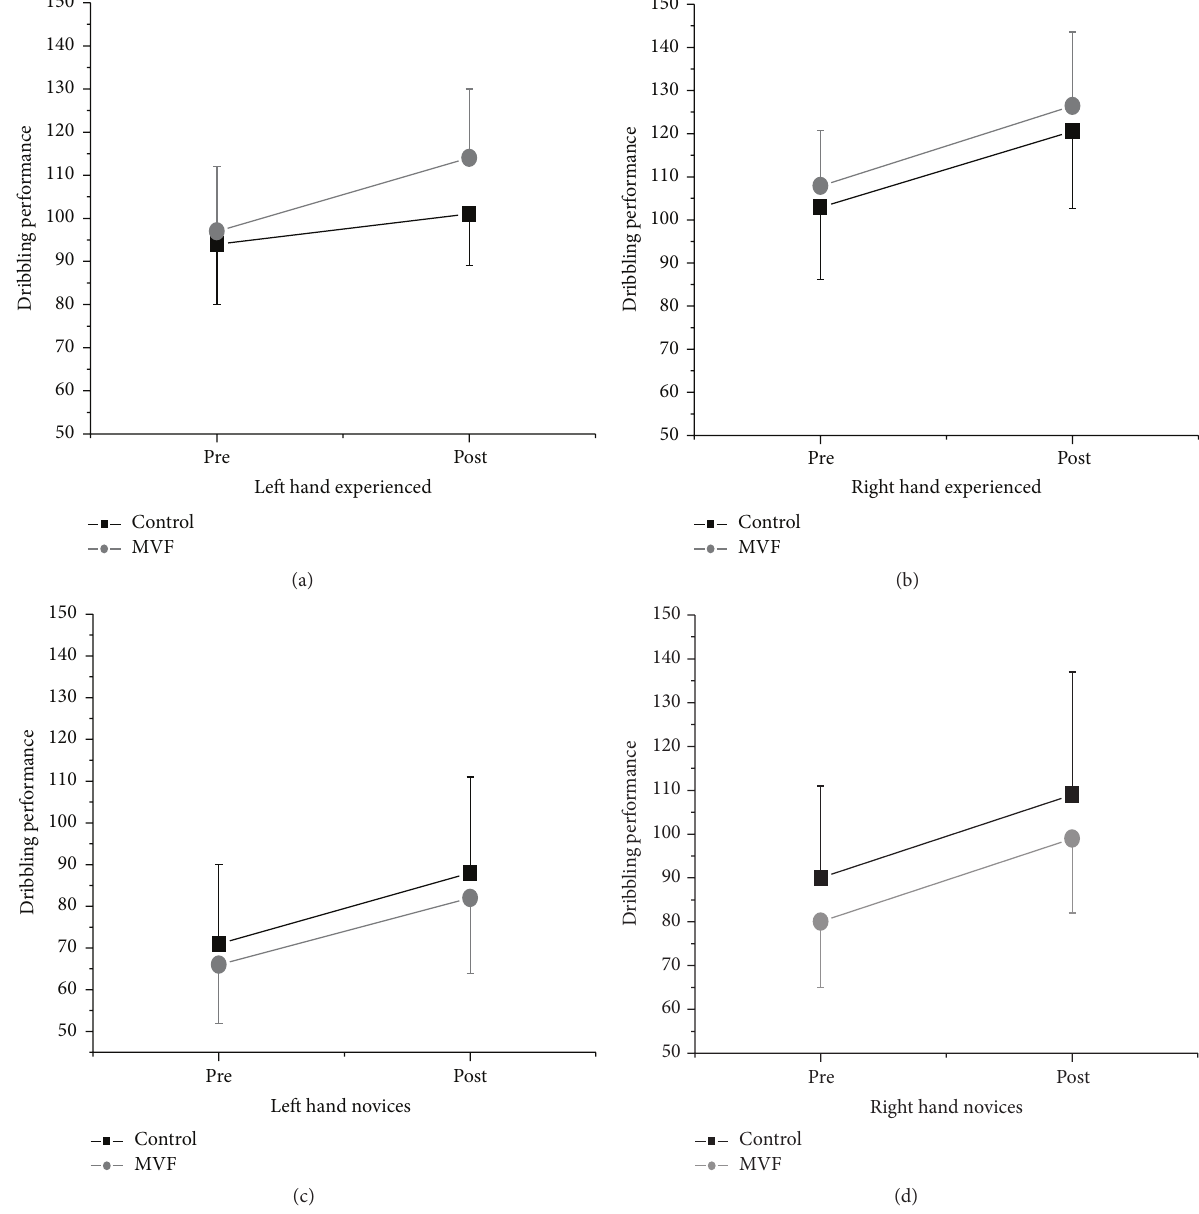
Figure 2: Interaction plots for the main outcome variable (dribbling performance) separated for novice and experienced groups and for left and right hand. Mean absolute scores are depicted and error bars indicate standard deviations; statistics are explained in the text.